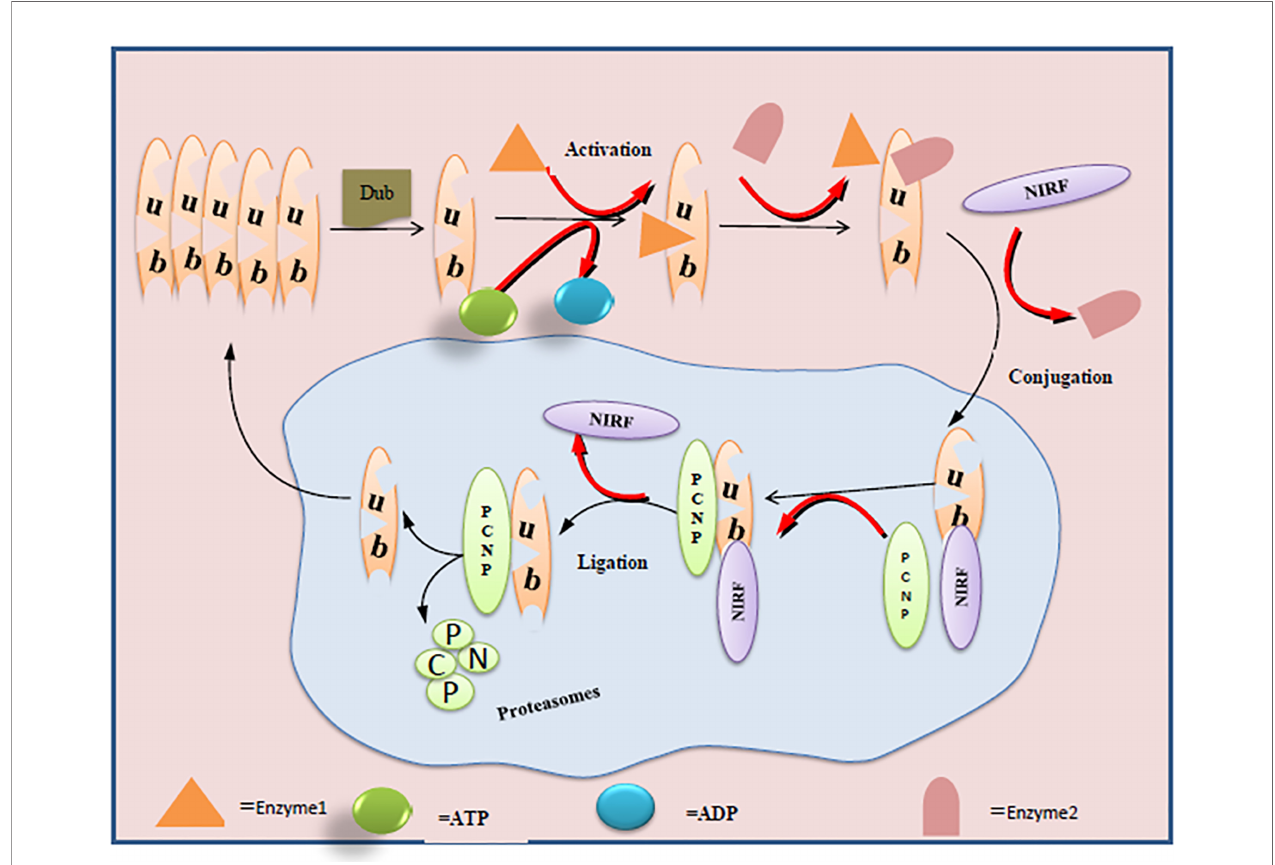
FIGURE 1 | Ubiquitination of PCNP by NIRF in the nuclear cell: ligase enzymes (E1, E2) facilitate the conjugation and ligation of NIRF with PCNP. C-terminus of NIRF performs the ubiquitin ligase function and acts on the PCNP as substrate and mediates the proteasome